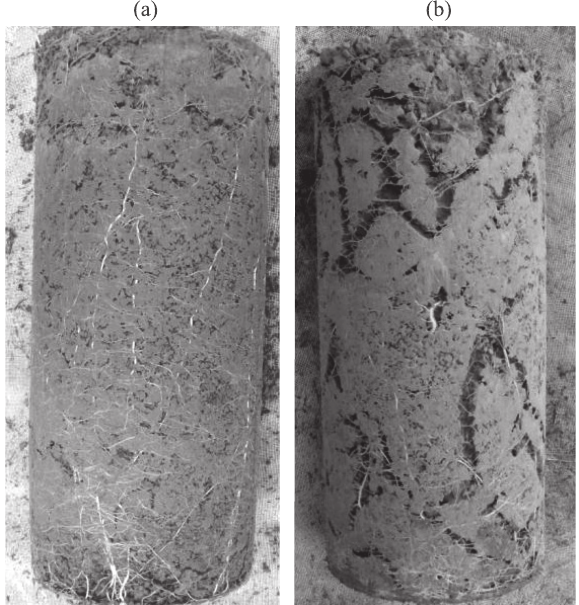
Figura 2. Aspecto do solo utilizado no cultivo do milho observado ao final do experimento, em função da ausência (a) e presença (b) de Chibui bari